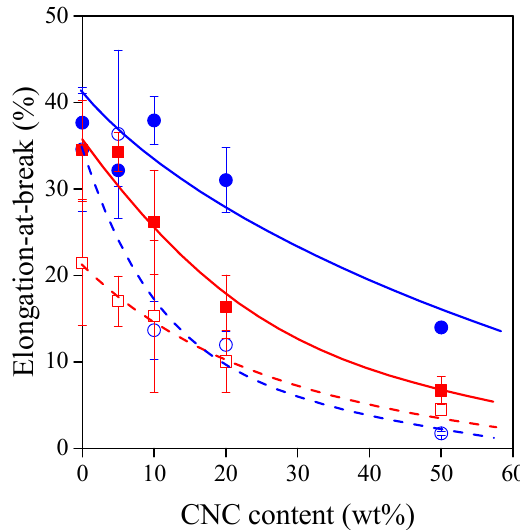
Figure 6. Elongation-at-break of TPS–CNC composites as a function of CNC content. Symbols: ( ) 30% glycerol; ( ) 40% glycerol; ( ) 30% sorbitol; ( ) 40% sorbitol.